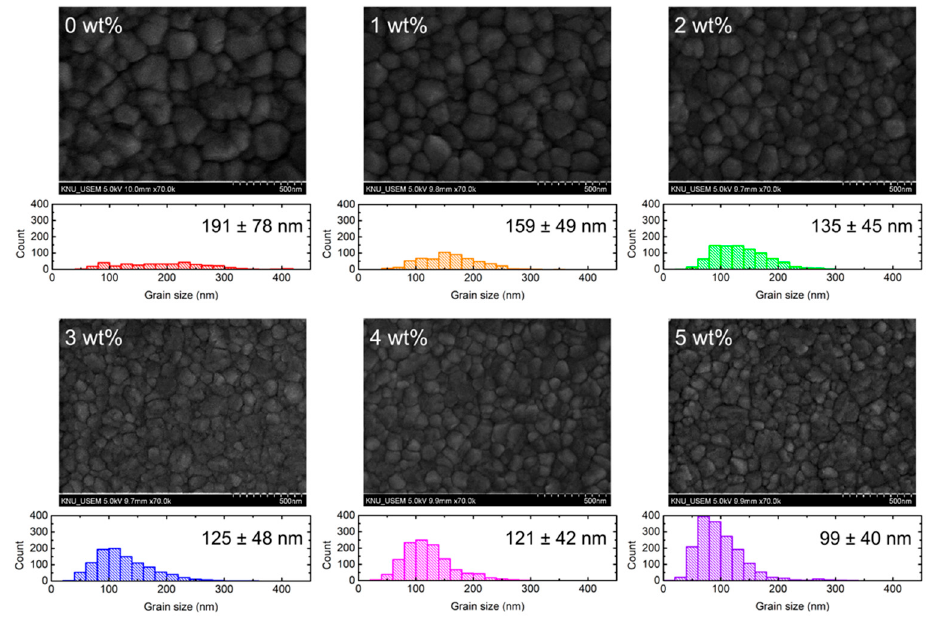
Figure 7. Top-view SEM images of perovskite film on Brij C10-modified (0, 1, 2, 3, 4, and 5 wt%) PEDOT:PSS/ITO and statistics of grain size.